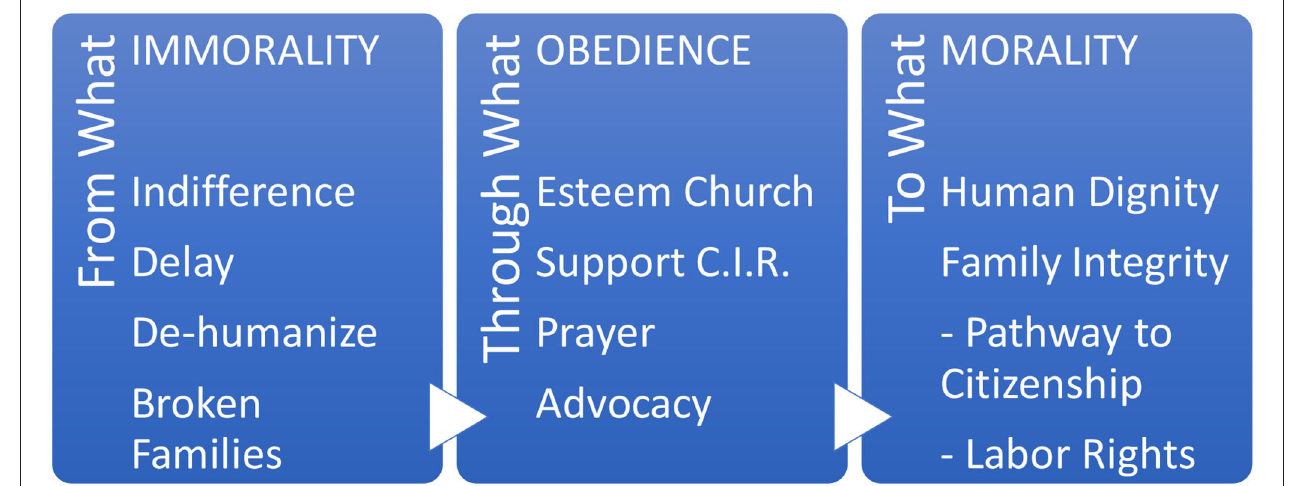
FIGURE 4 | Narrative